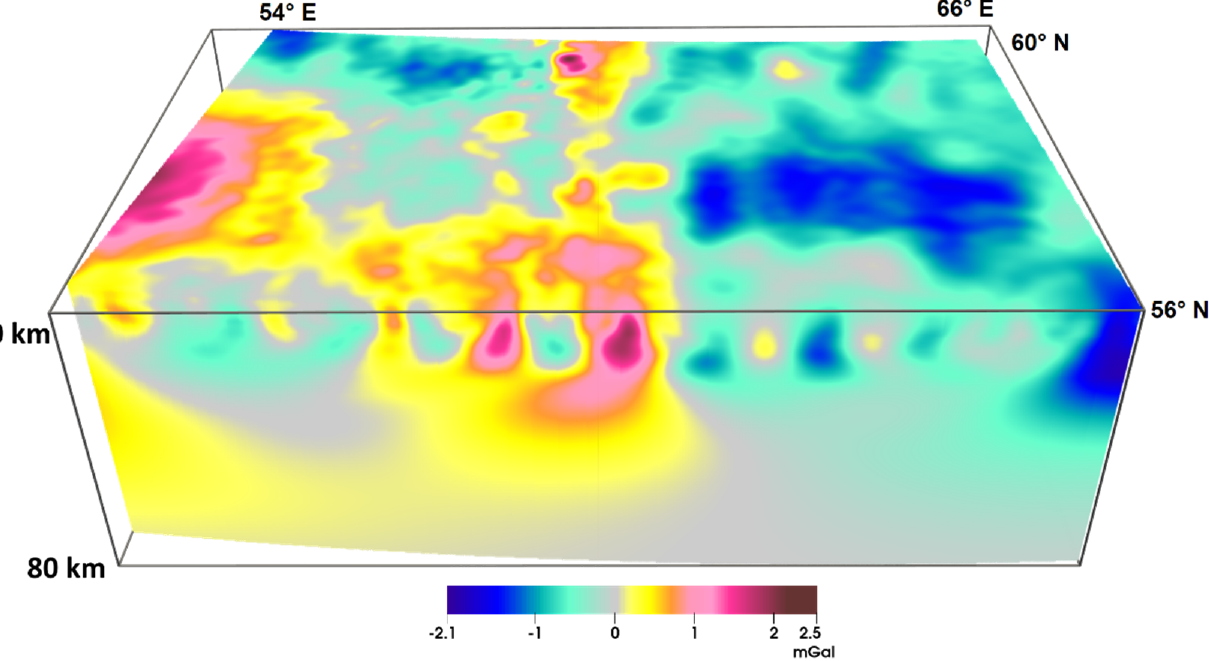
Figure 8. Examples of the different field separations. The minimum and maximum of amplitude of the field are also shown. The ranges of depths of the layer are (1) H ∊ [0, 5] km, Δ g ∊ [ − 8.8, 15.1] mGal; (2) H ∊ [5, 20] km, Δ g ∊ [ − 35.3, 54.3] mGal; (3) H ∊ [20, 40] km, Δ g ∊ [ − 26.7, 34.8] mGal; and (4) H ∊ [40, 80] km, Δ g ∊ [ − 12.2, 17.7] mGal. The masses in the layer are considered to be the sources of the separated field.